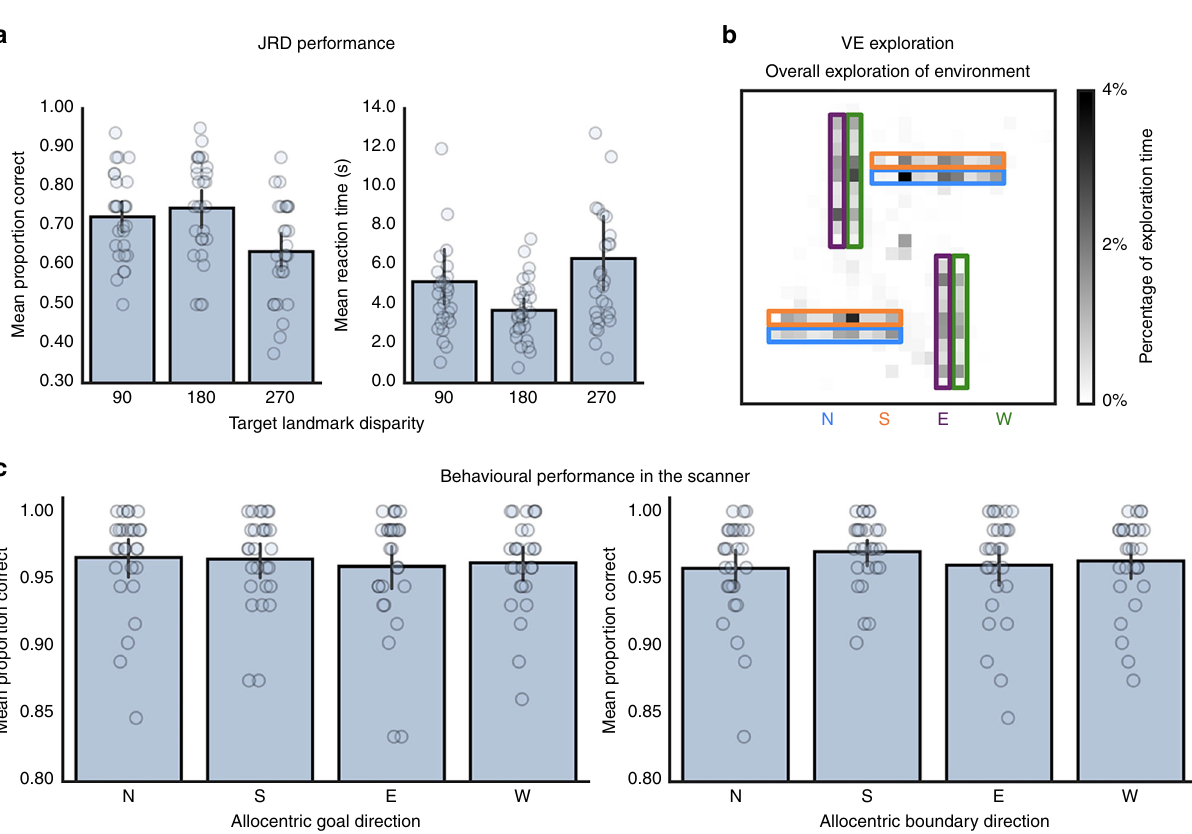
Fig. 1 Mean performance during the learning phase and fMRI scan task. a On the JRD task, participants made more accurate judgements regarding landmarks located either at 180°, or 90° angular disparity, and made the fastest responses for landmarks located at 180° disparity. b Exploration time in the environment was matched across the four different allocentric boundary directions. c In the fMRI scan task, accuracy was matched for allocentric goal direction, and the same was true when grouping the trials according to allocentric boundary direction. Individual subject ’ s data points are represented by grey circles. Error bars represent the 95% CI. Source data are provided as a Source Data fi